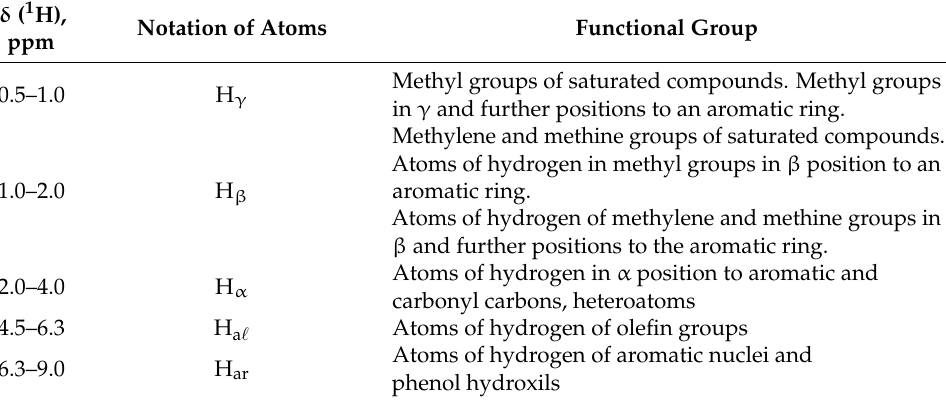
Table 3. Variation limits and interpretation of chemical shifts of 1 H